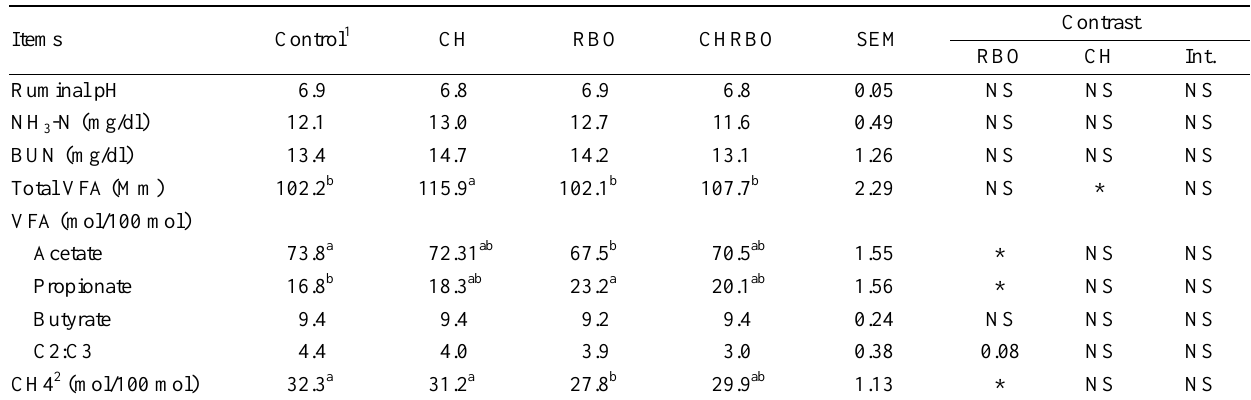
Table 4. Effect of cassava hay and rice bran oil on rumen fermentation characteristics and blood urea nitrogen in lactating dairy